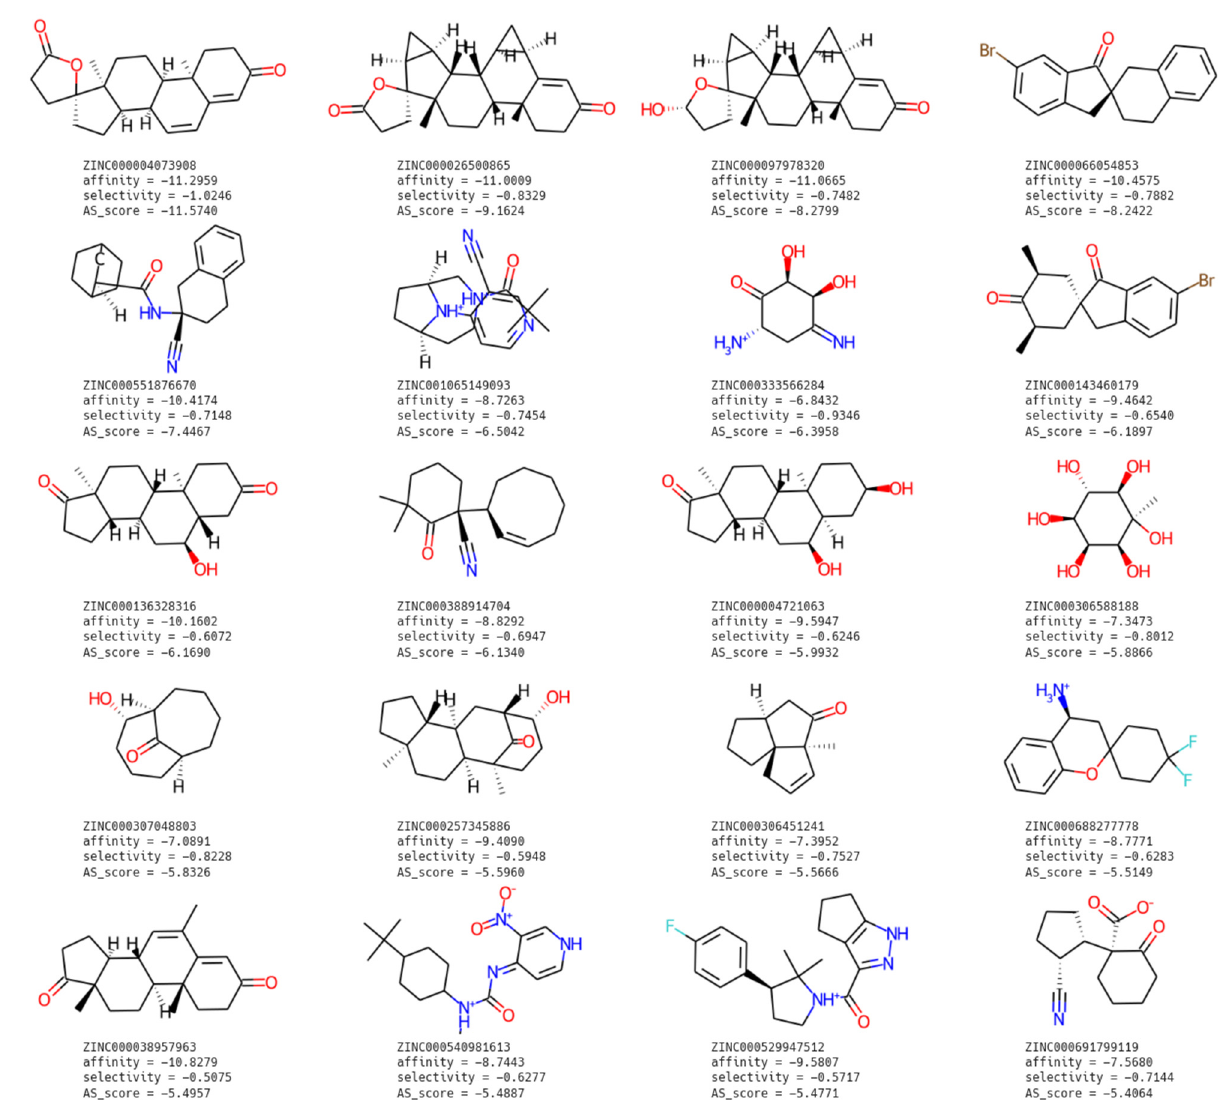
Figure 1. Best molecules at the end of computation.